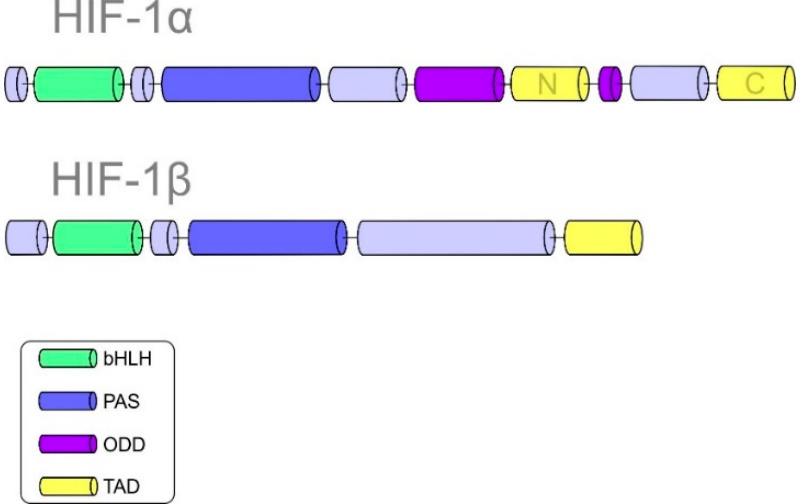
Figure 1. Domain structures of hypoxia-inducible factor 1 (HIF-1 α ) and HIF-1 β .